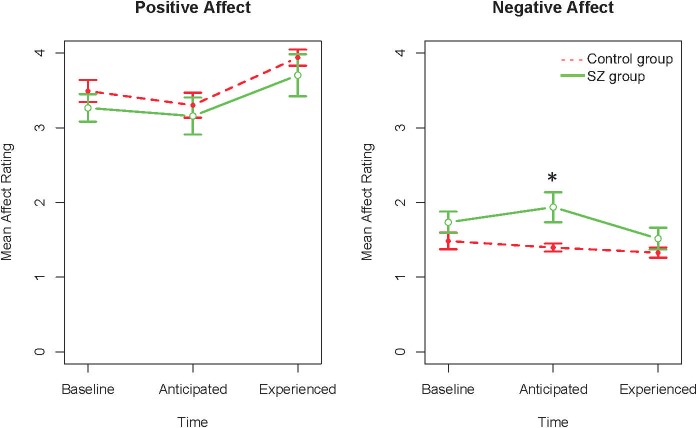
Positive and negative emotion ratings at each time point by group.The significant group difference is denoted with an asterisk.